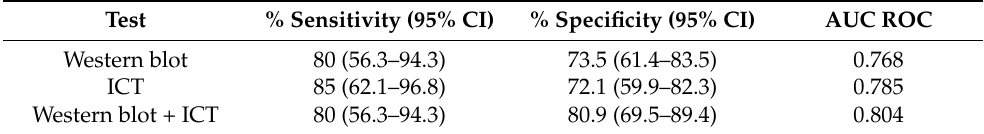
Table 2. Diagnostic performances of Aspergillus Western blot and immunochromatography (ICT) tests.